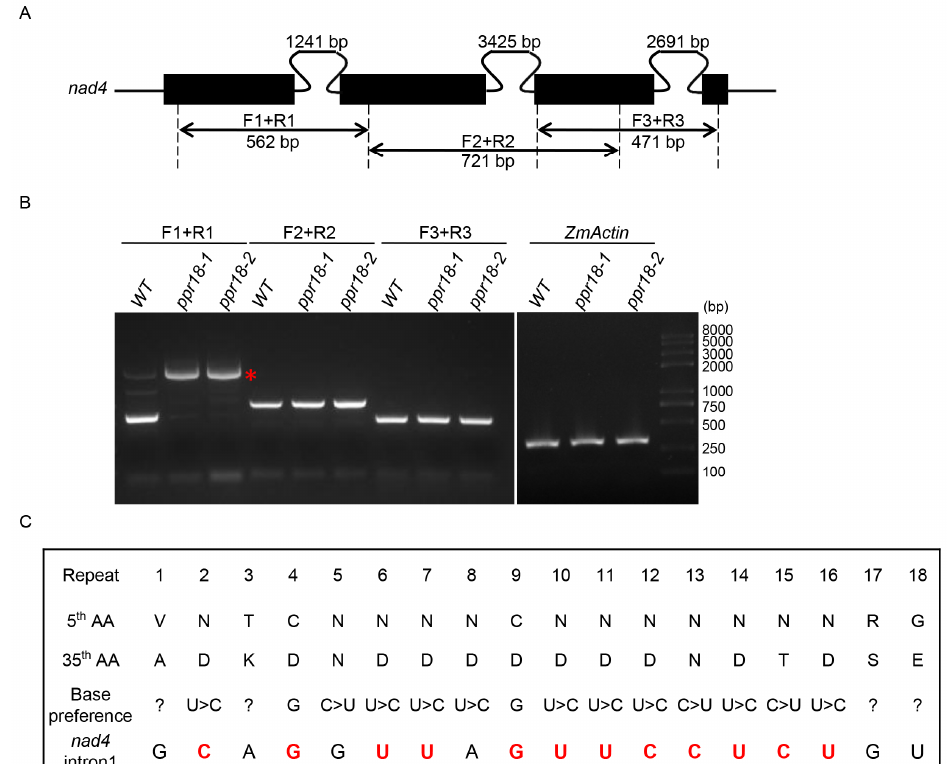
Figure 6. The ppr18 mutants are impaired in the splicing of nad4 intron 1. ( A ) Gene structure diagram of the maize nad4 gene. Exons are shown as filled black boxes. All the three introns of nad4 are cis -introns. The primers and expected amplification products using are indicated. F: Forward primer, R: Reverse primer. ( B ) RT-PCR analysis of the intron splicing of nad4 introns using primers as indicated in ( A ). Asterisk indicates the unspliced PCR products of nad4 intron 1. ( C ) Binding predictions for the PPR18 proteins on the respective targets nad4 intron 1 referred to Barkan et al., 2012; Yin et al., 2013; and Gully et al., 2015. The amino acid (AA) residues at position 5th and 35th in PPR motifs 1–18 are indicated. Nucleotides matching the amino acid combination are indicated in red. “?” indicates an unidentified nucleotide. Int. J. Mol. Sci. 2020 , 21 , x FOR PEER REVIEW